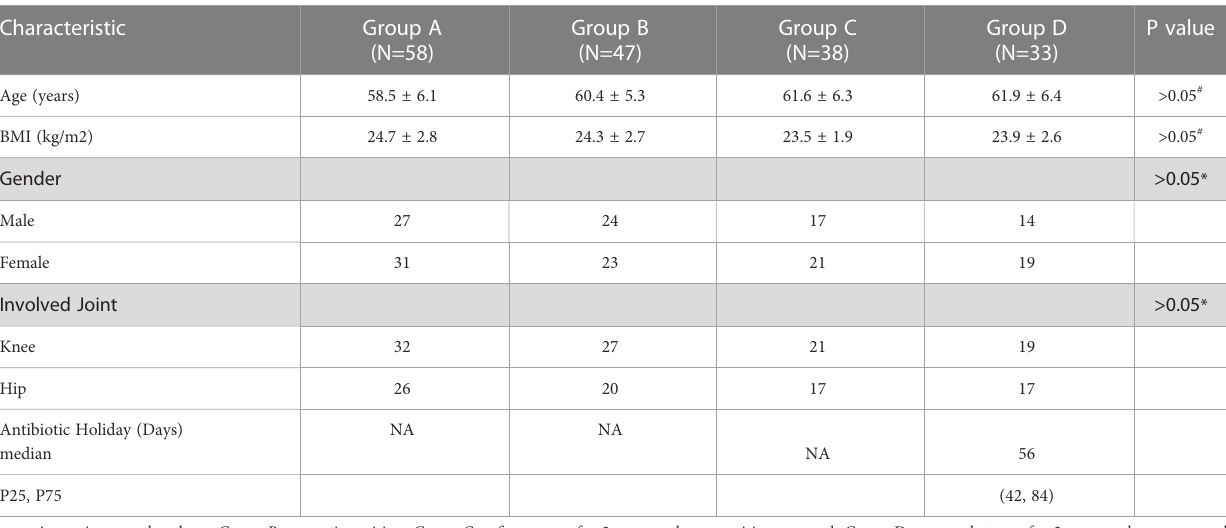
TABLE 1 Demographic data for the study